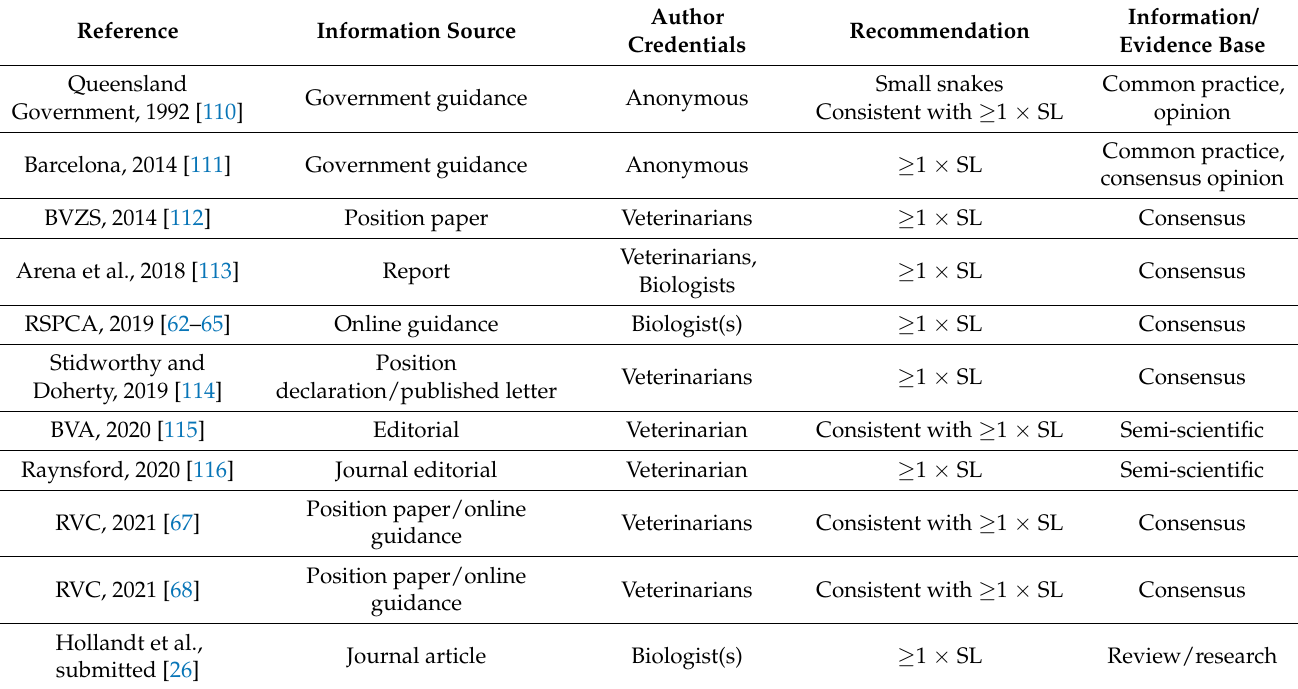
Table 5. Summary of findings from grey literature * for information sources and recommendations consistent with or specifying ≥ 1 × snake length (SL) minimum enclosure size.